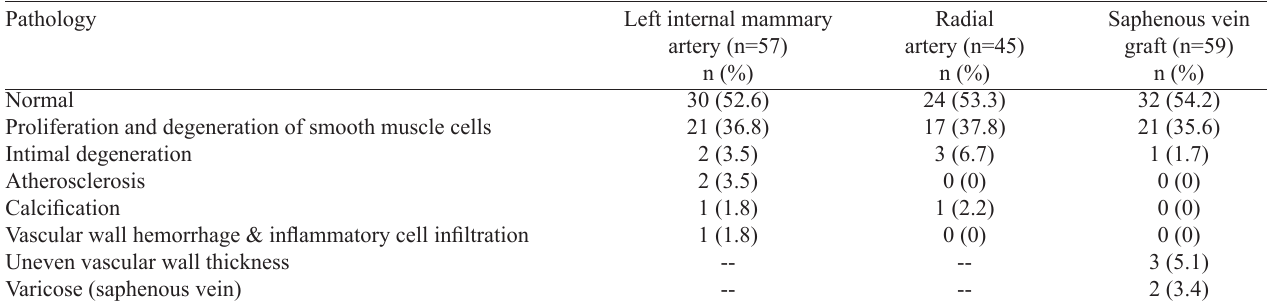
Table 4. Pathology of the inspected remnants of the grafts.